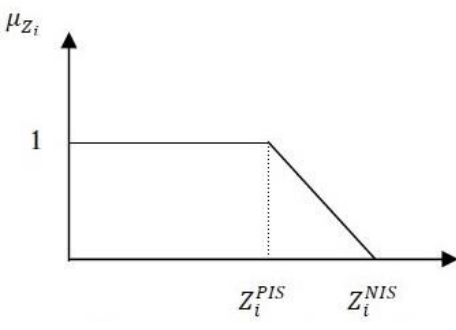
Figure 2. Linear membership function for each objective ( 𝑖 = 1, 2, 3